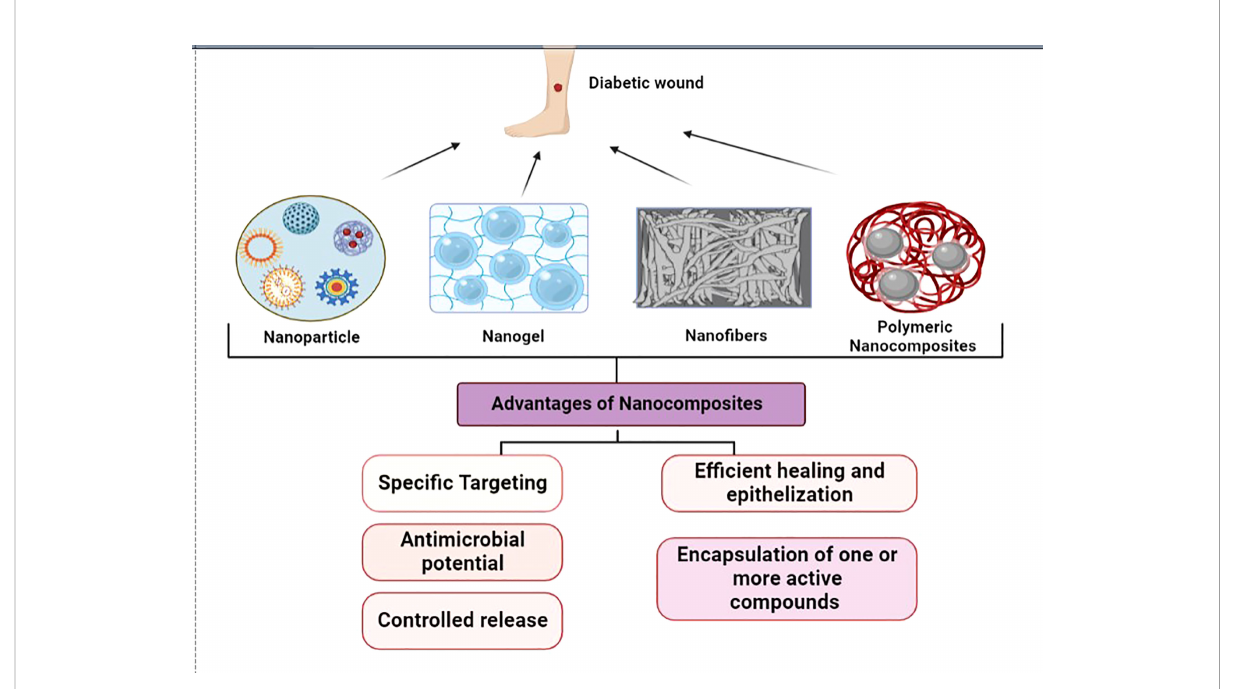
FIGURE 1 Types of nanocomposites and its advantages as a wound